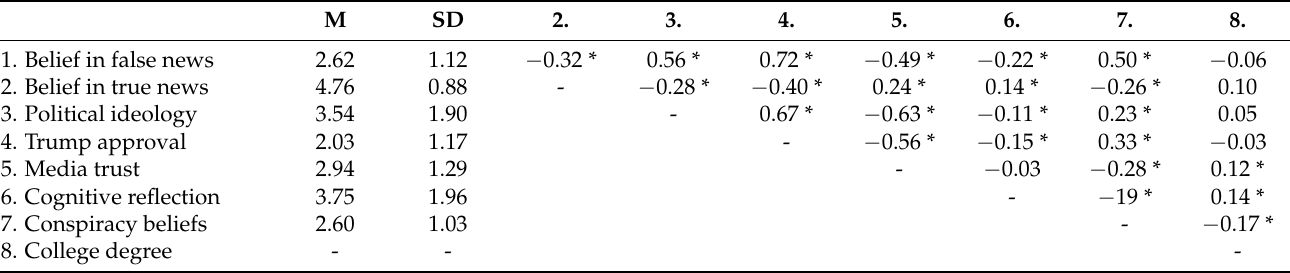
Table 1. Means, standard deviations, and intercorrelations of belief in fake news and individual difference measures employed in the study.